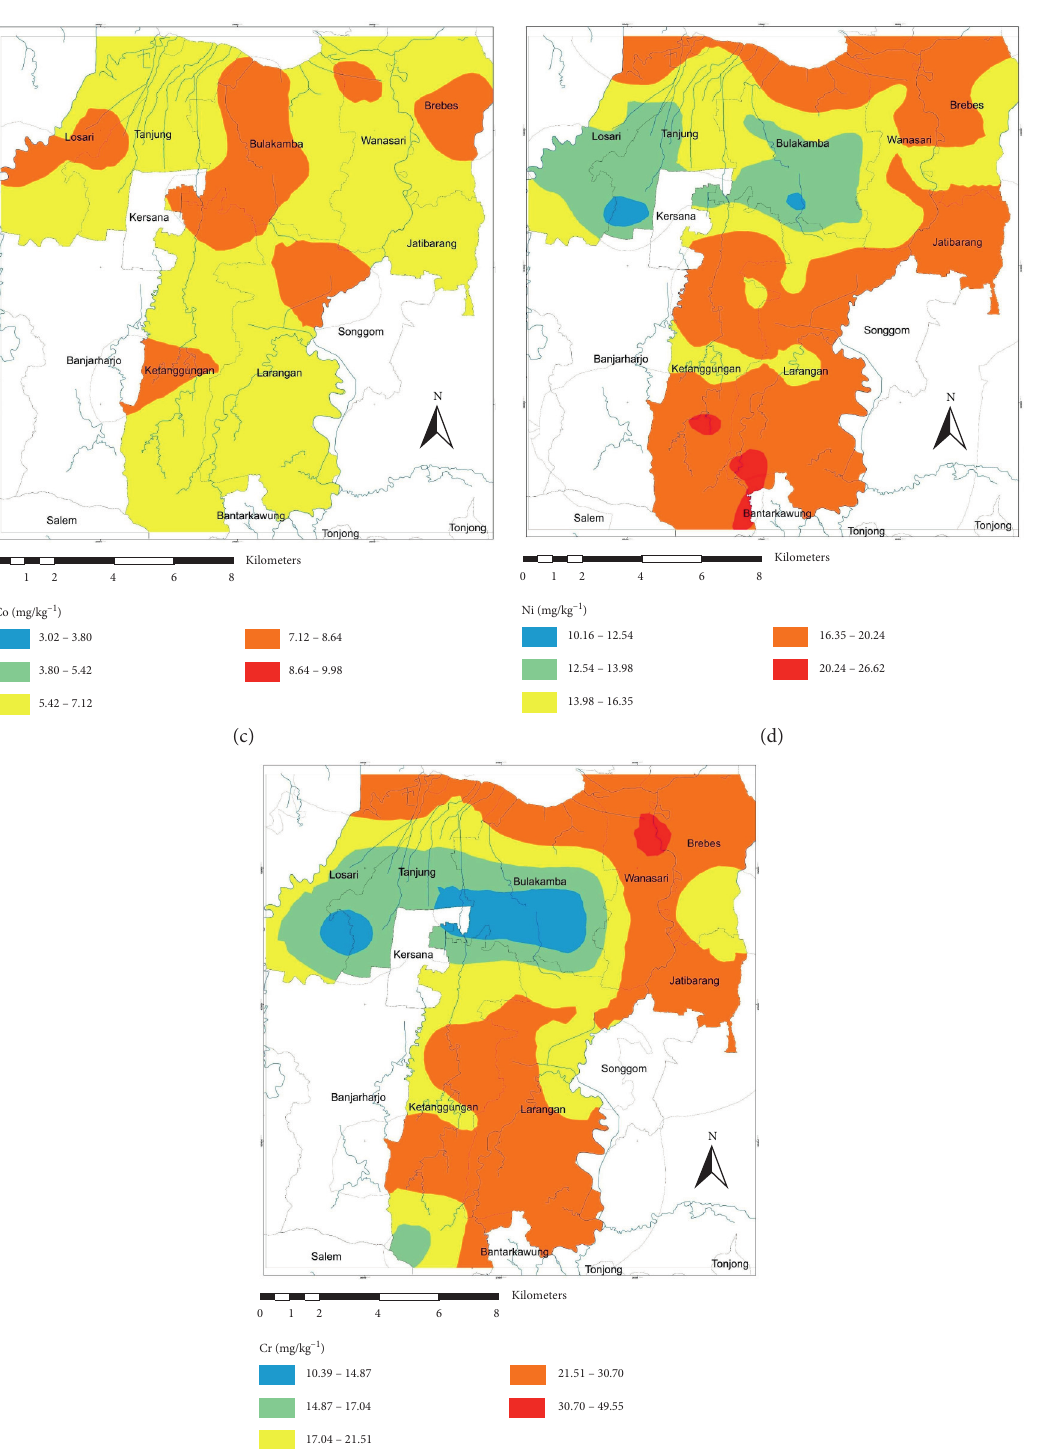
Figure 5: Spatial distribution maps of heavy metal concentrations in the soil of shallot fields in Brebes Regency, Central Java,